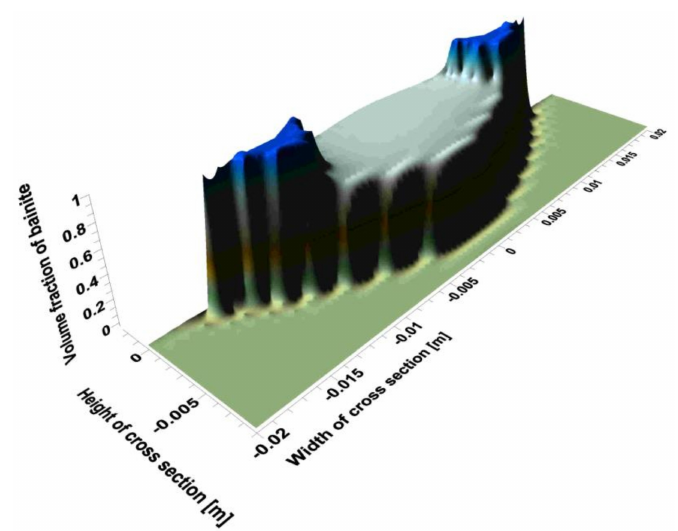
Figure 9. Distribution of bainite share in padded weld.